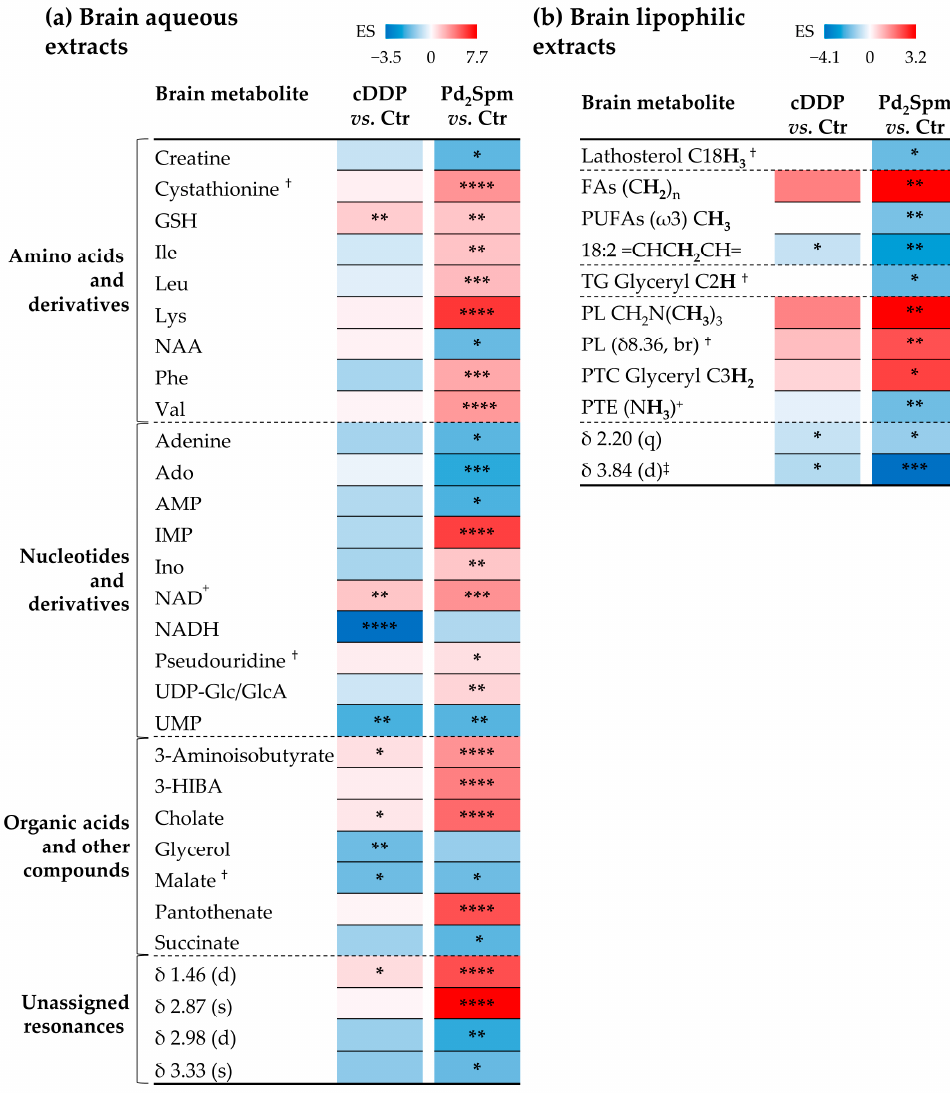
Figure 3. Heatmaps illustration of the effect size (ES) values of statistically significant variations in the ( a ) aqueous, and ( b ) lipophilic extracts of the brain of TNBC xenografts exposed to cDDP or Pd 2 Spm in comparison to controls. Metabolic variations are colored from blue to red, representing an increasing ES scale from negative to positive values, respectively. Abbreviations: ( a ) as defined in Figure 1; ( b ) FAs, fatty acids; PLs, phospholipids; PTC, phosphatidylcholine; PTE, phosphatidylethanolamine; PUFAs, polyunsaturated fatty acids; TG, triacylglycerols; s, singlet; d, doublet; q, quartet; br, broad signal. † Tentative assignment. ‡ Partial integration of resonance peak. * p -value < 5.0 × 10 − 2 ; ** p -value < 1.0 × 10 − 2 ; *** p -value < 1.0 × 10 − 3 ; **** p -value < 1.0 × 10 − 4